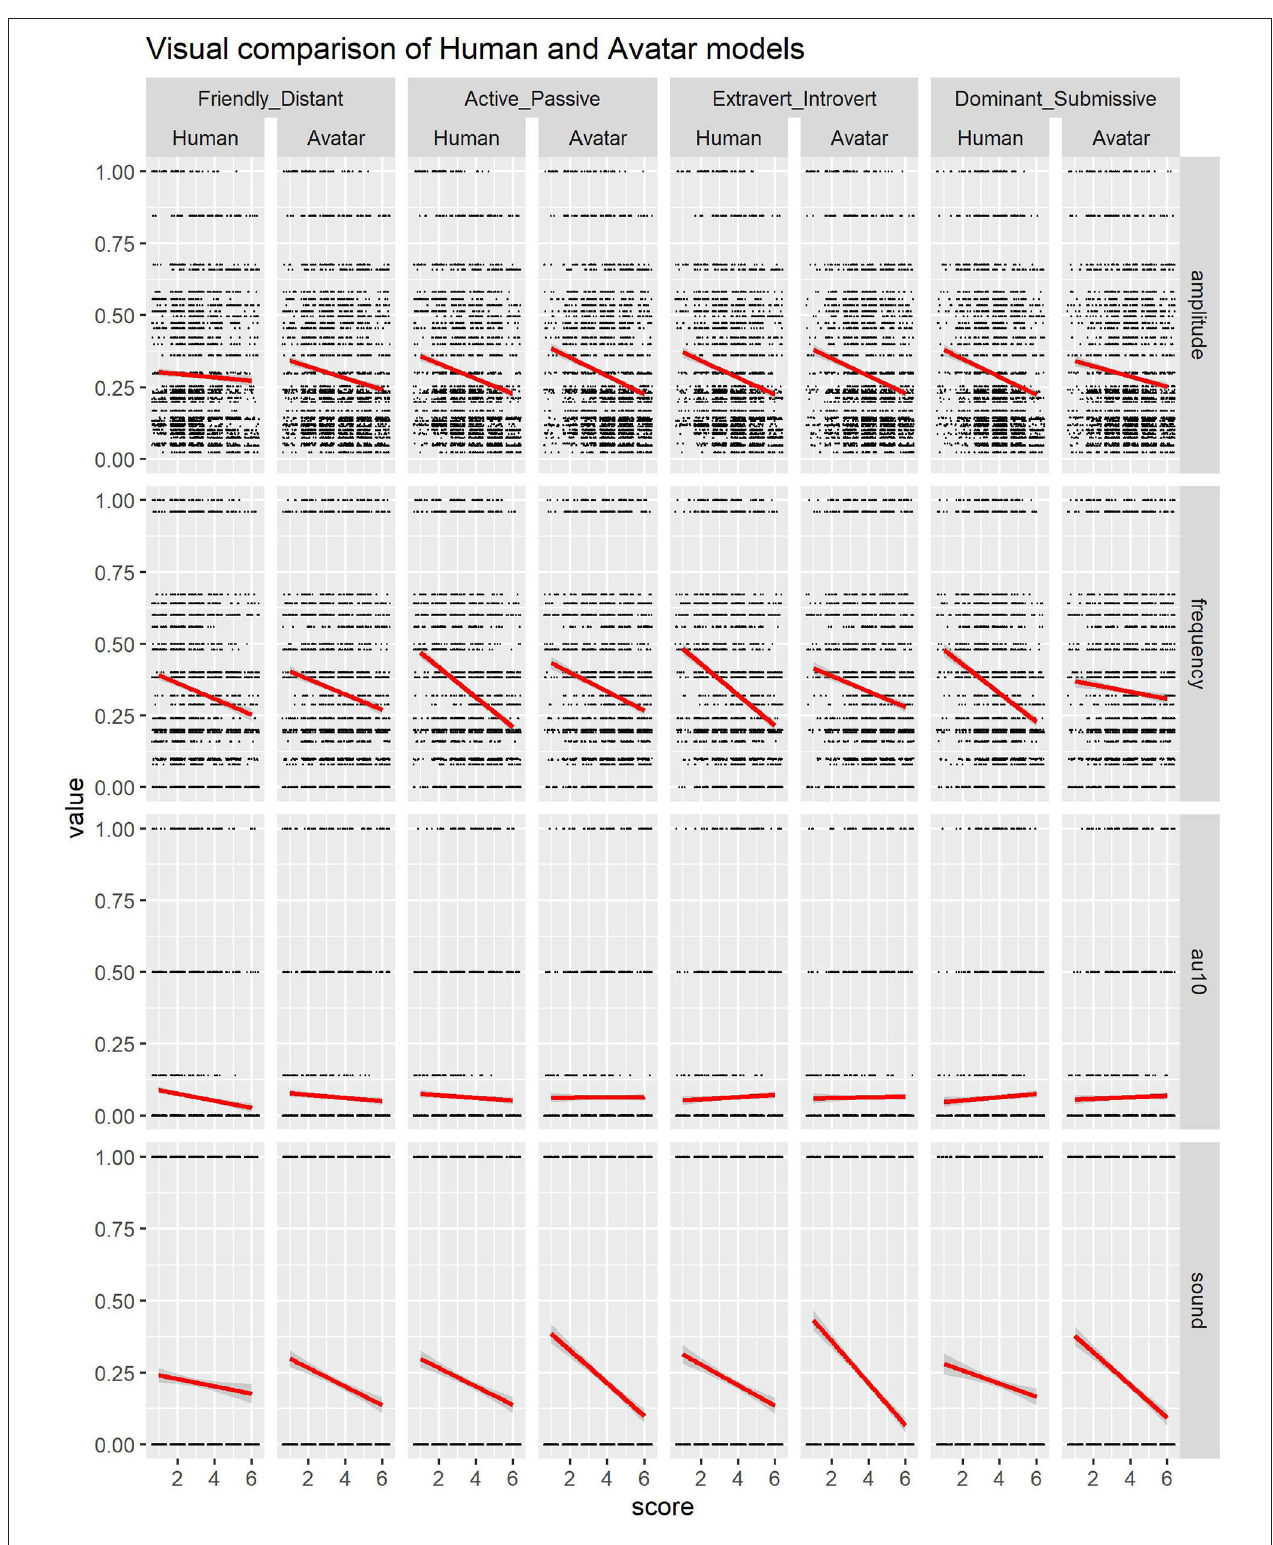
FIGURE 6 | Visual indication of distributions for all variables available in Avatar